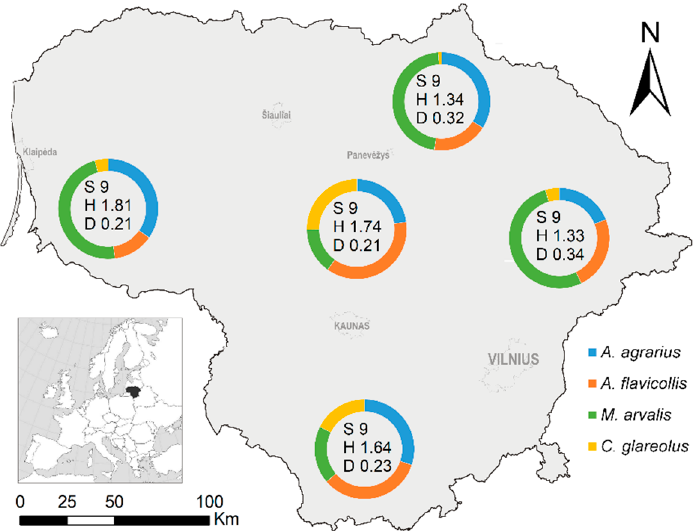
Figure 3. Proportions of the four most abundant small mammal species from the commercial orchards in different parts of Lithuania, 2018–2020. S—number of species, H—diversity, D— dominance indices.